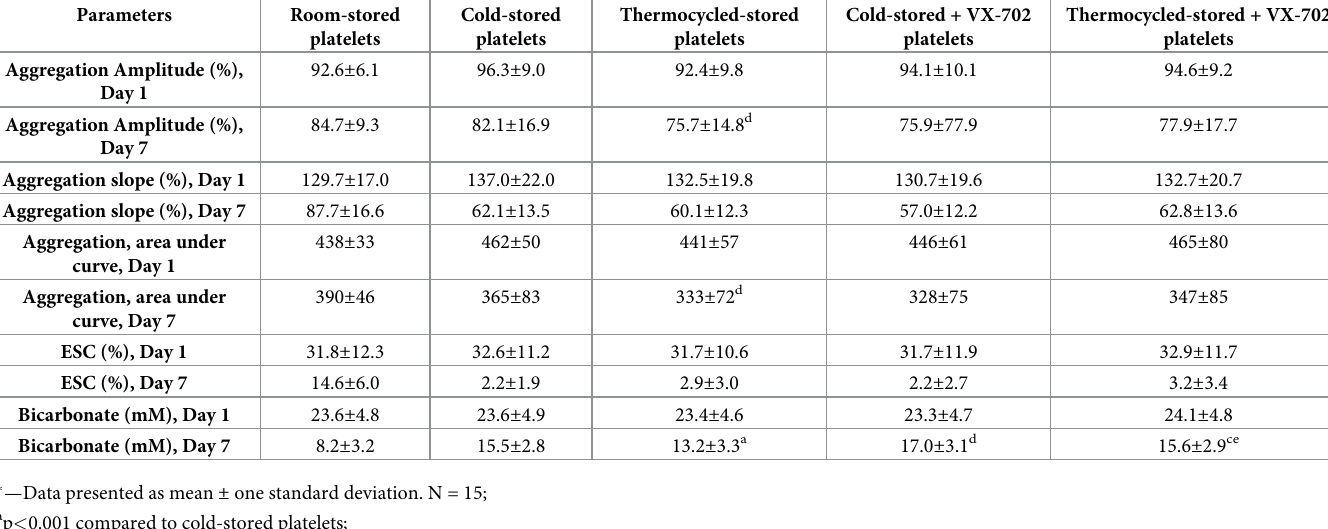
Table 1. Values of platelet parameters on Days 1 and 7 of the storage � .